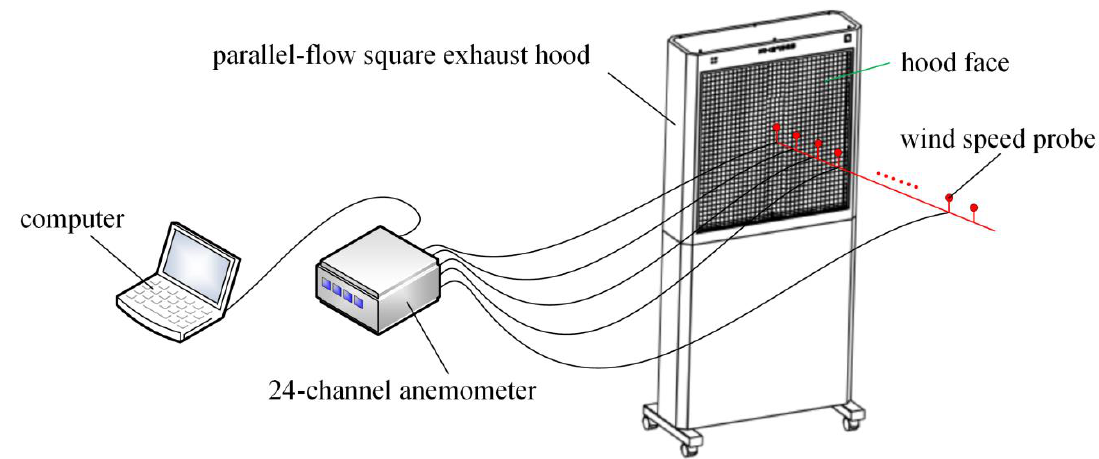
Figure 7. The schematic diagram of center-line velocity detection setup.